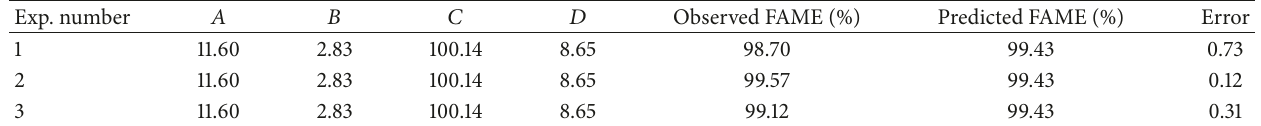
Table 5: Optimum reaction conditions and validation test.